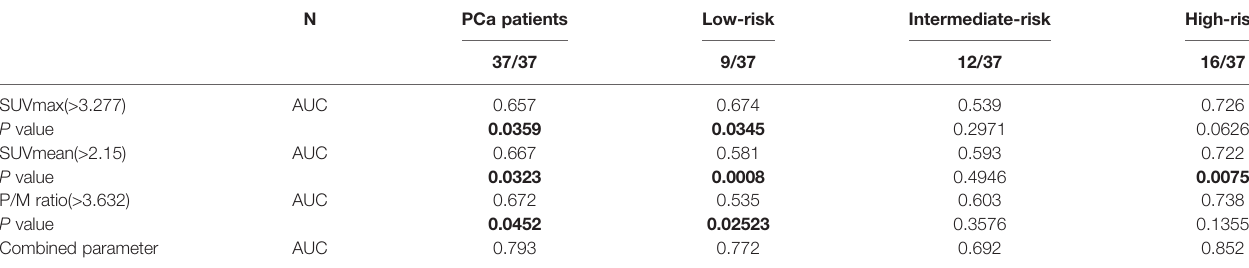
TABLE 3 | Predictive value of different parameters in veri fi cation set.